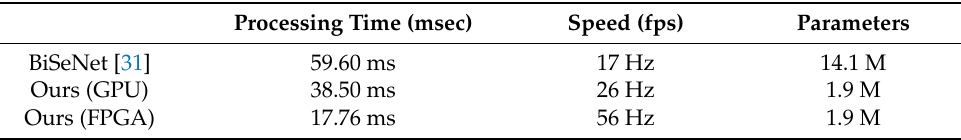
Table 2. Run-time performance on the SemanticKITTI test set.